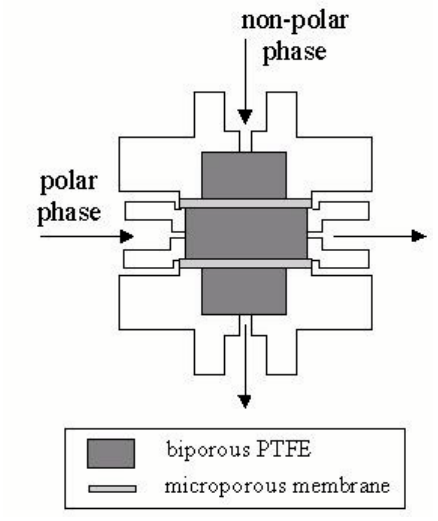
Figure 1. The Chromatomembrane Cell (from